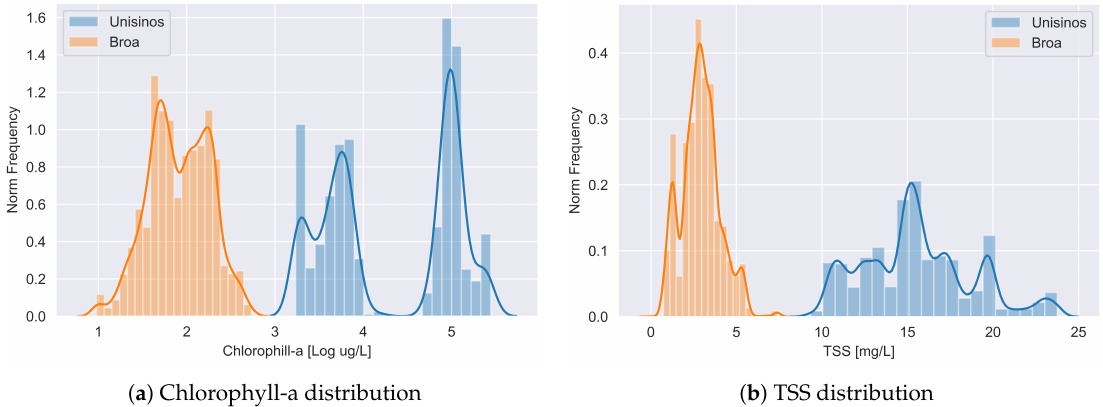
Figure 4. Dependent variables’ distribution from both study areas considering the data post-IDW